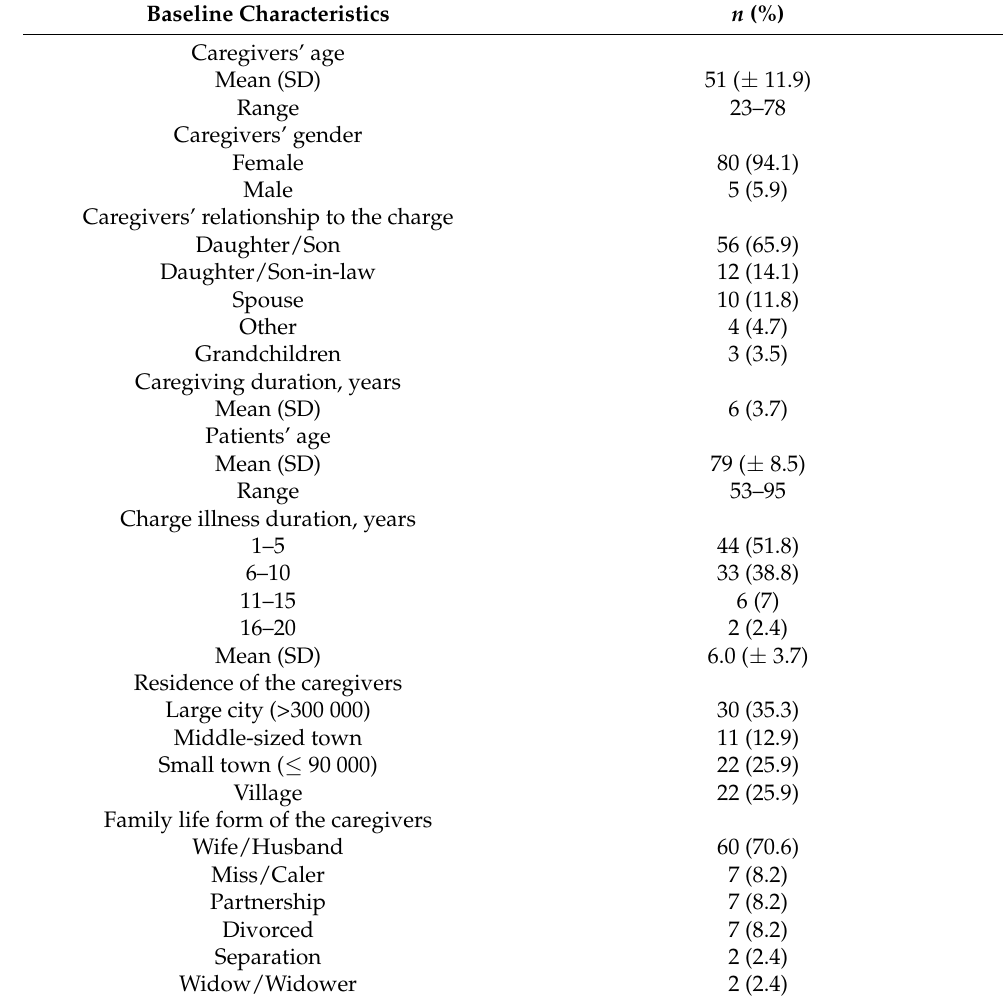
Table 1. Characteristics of caregivers of charges with Alzheimer’s Disease. Abbreviations: SD— standard